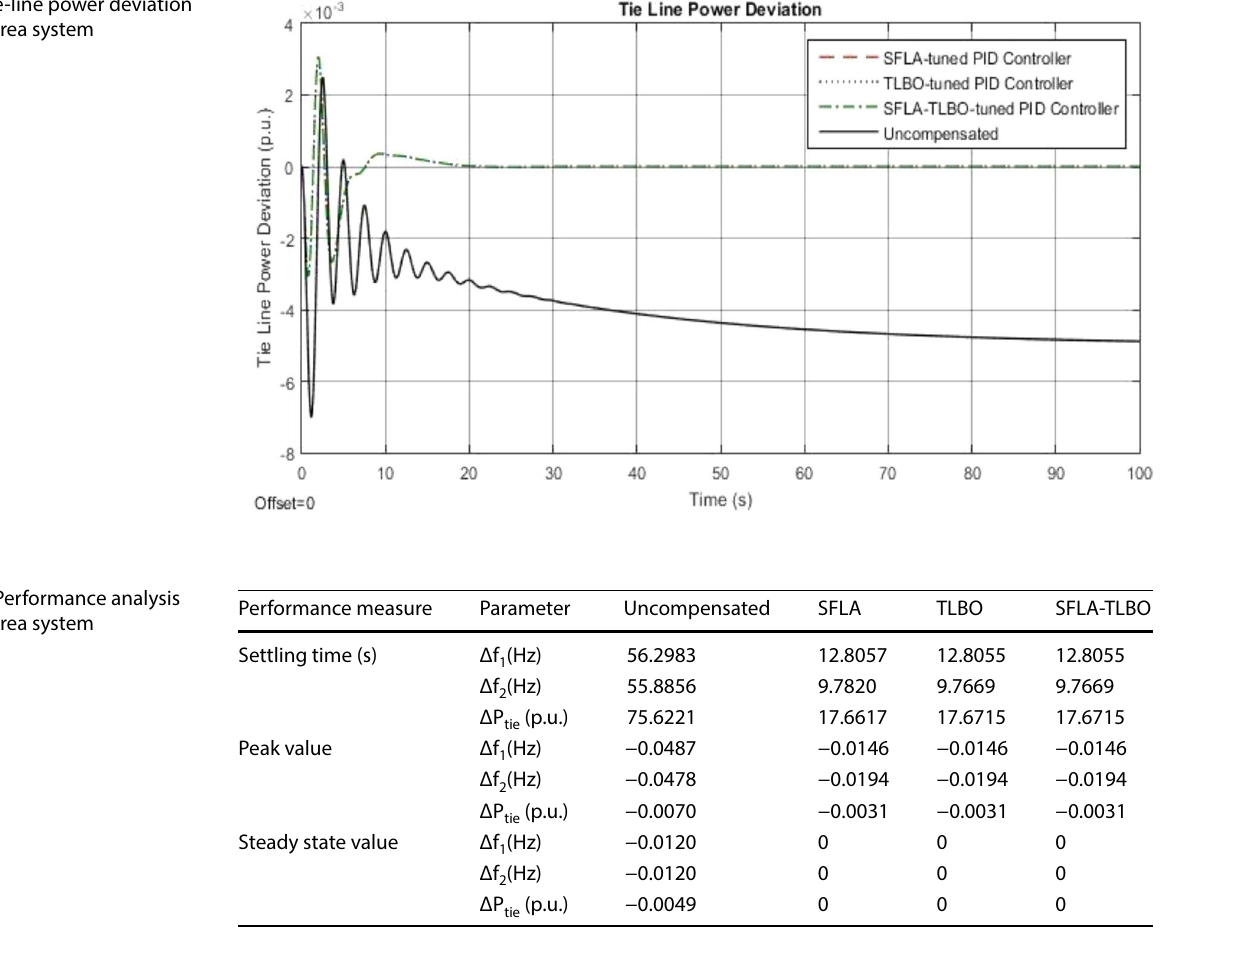
Table 5 Optimal solutions for non-linear two-area system Optimisation techniques